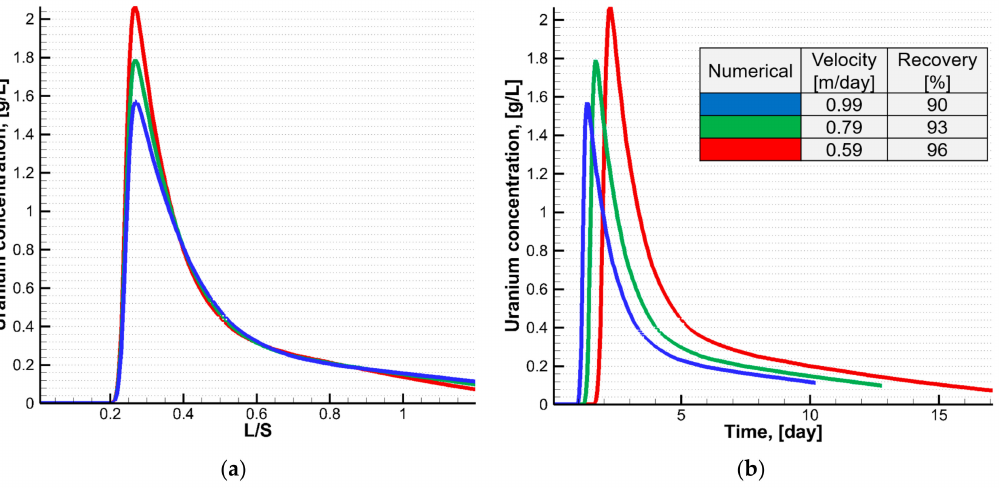
Figure 8. Dissolved uranium concentration at the tube outlet for three solution filtration rates (namely, 0.99, 0.79 and 0.59 m.day − 1 ) imposed at the tube inlet, plotted against ( a ) the L/S ratio (equivalent to a dimensionless time) and ( b ) the time for different values of the filtration